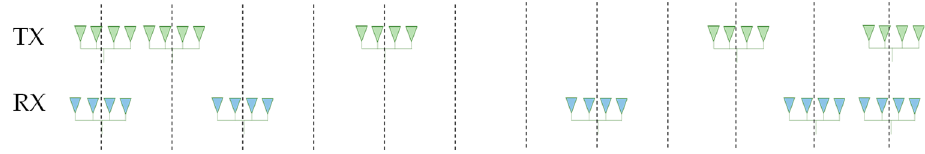
Figure 15. Non-redundant MIMO configuration. The ratios of the spacing among subarrays are